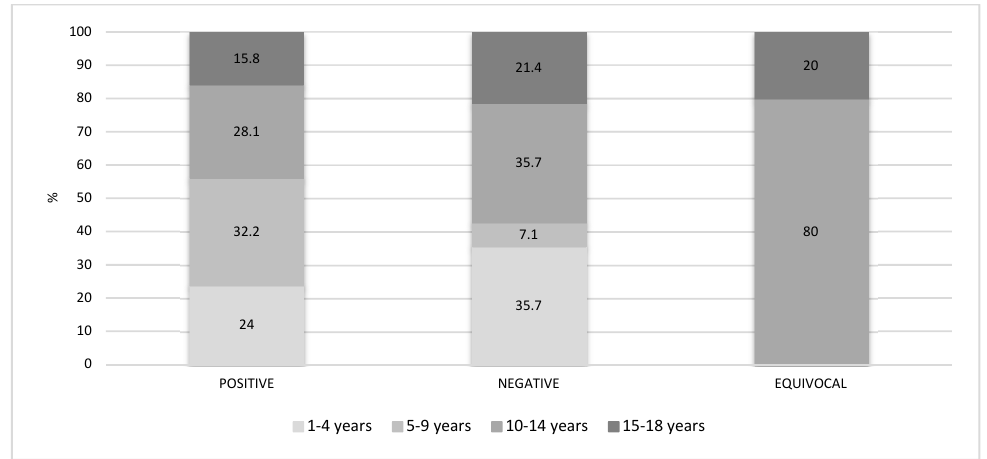
Figure 2. Age group percentage distribution of the positive, negative and equivocal subjects.